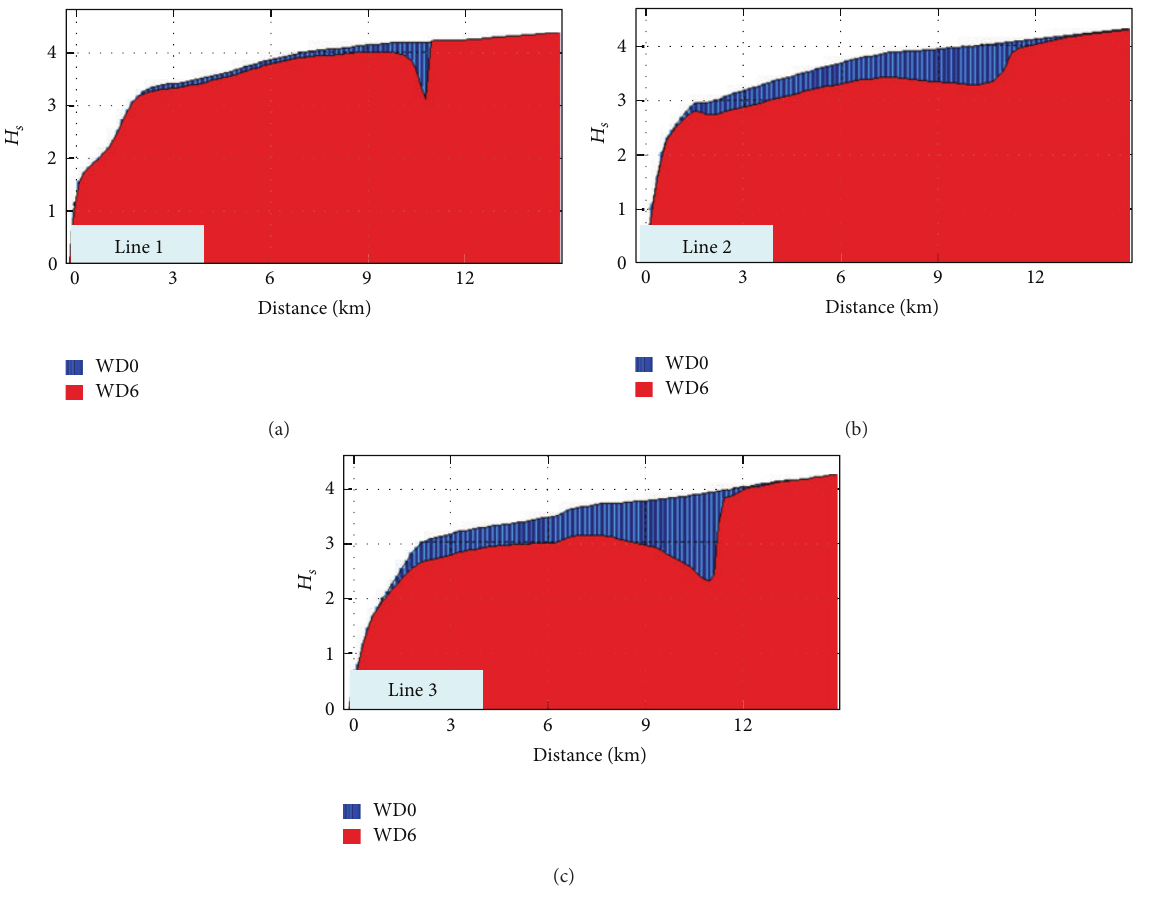
Figure 18: 𝐻 𝑠 variation along the three reference lines without and with the WEC array (WD0 and WD6) for the wave conditions corresponding to the parameters: 𝐻 𝑠 = 5 m, 𝑇 𝑚 = 8 s, and Dir= 30 ∘